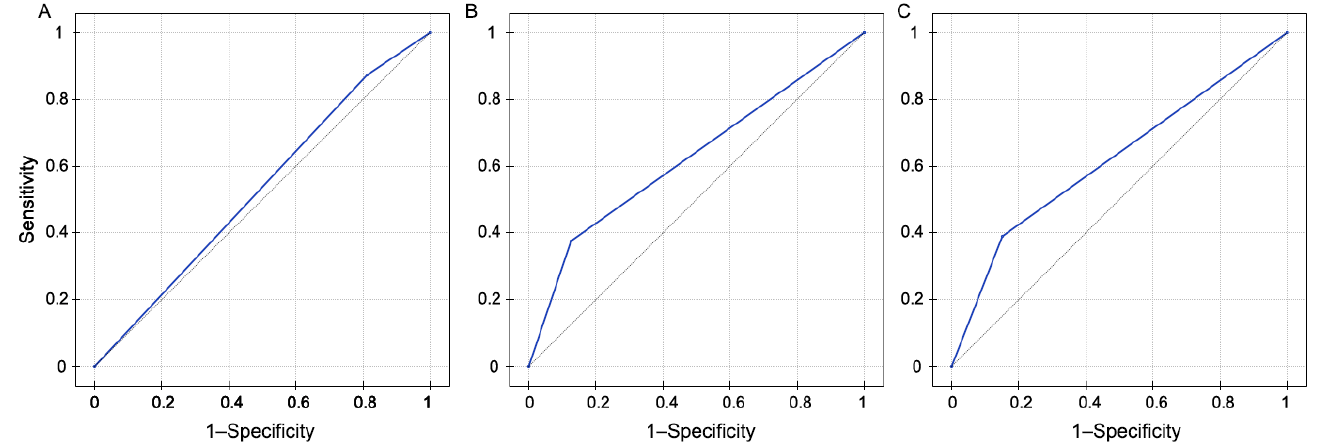
Figure 1. ROC curves for GCIPL thickness <70 µm ( A ), pRNFL thickness ≤87 µm ( B ) and ≤88 µm ( C ). ROC, receiver operating characteristic; GCIPL, ganglion cell–inner plexiform layer; pRNFL, peripapillary retinal nerve fiber layer.